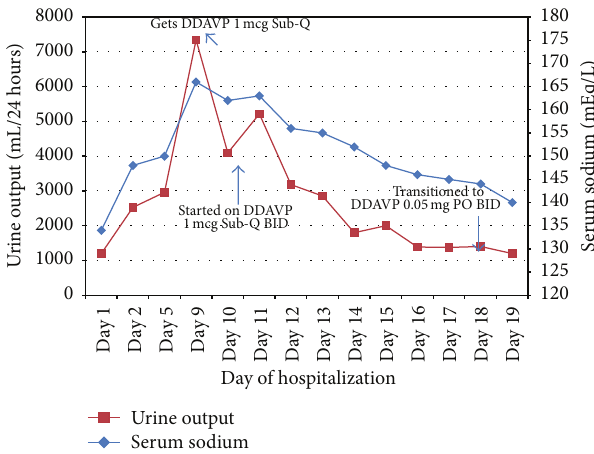
Figure 1: Graph of patient’s serum sodium and urine output in response to desmopressin over hospital course. Sub-Q: subcuta- neous; DDAVP: desmopressin; PO: per os; BID: twice